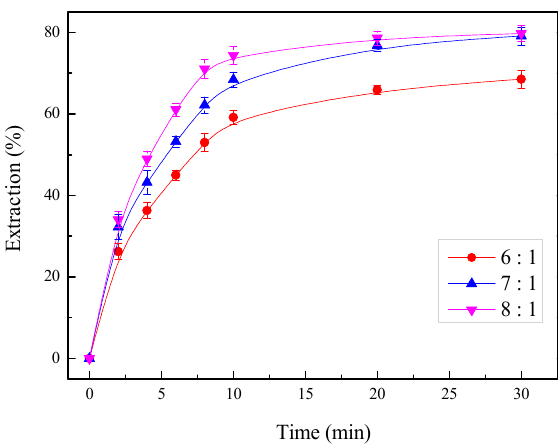
Figure 13. Effect of the liquid/solid ratio on the zinc extraction.